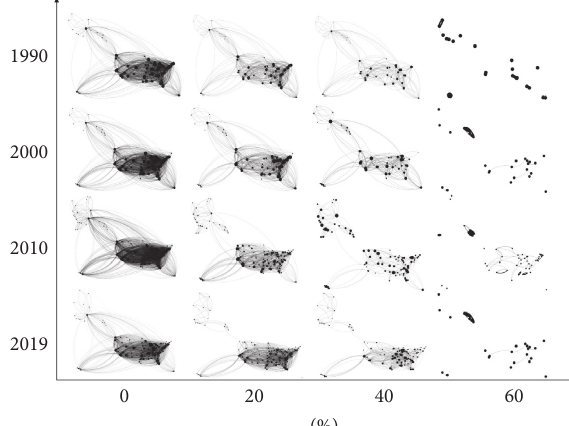
Figure 6: Robustness of the USACN under attacks based on betweenness centrality from 1990 to